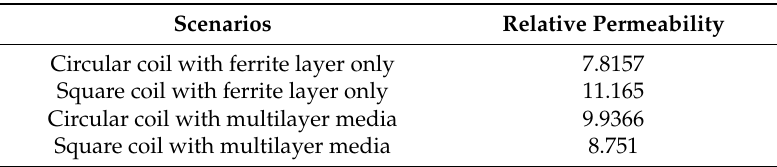
Table 4. Equivalent relative permeability of each scenarios.